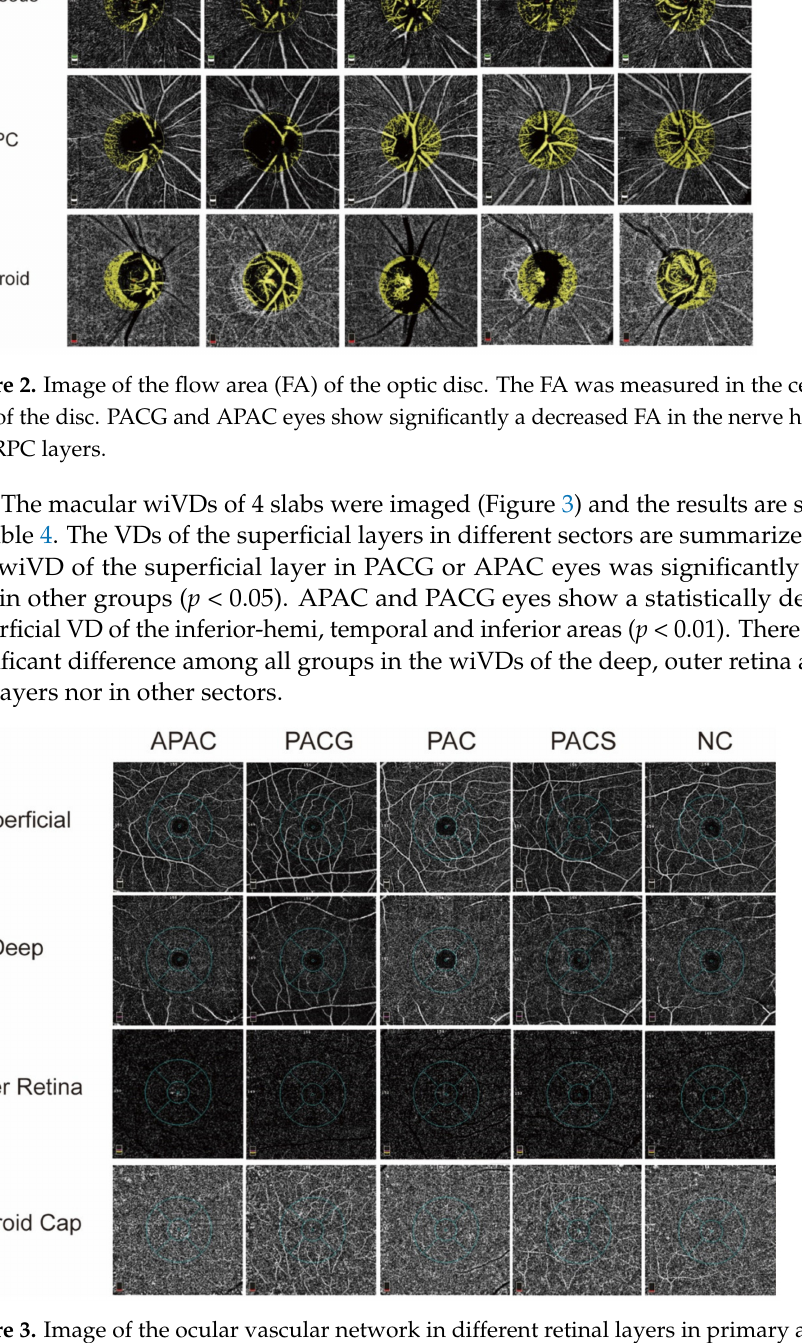
Figure 3. Image of the ocular vascular network in different retinal layers in primary angle-closure diseases (PACD) and healthy eyes. A comparison of the vascular density in the superficial, deep, outer retinal, and choroid cap layers in foveal and parafoveal areas are presented. APAC = acute primary angle-closure; PACG = primary angle-closure glaucoma; PAC = primary angle-closure; PACS = primary angle-closure suspect; NC = normal